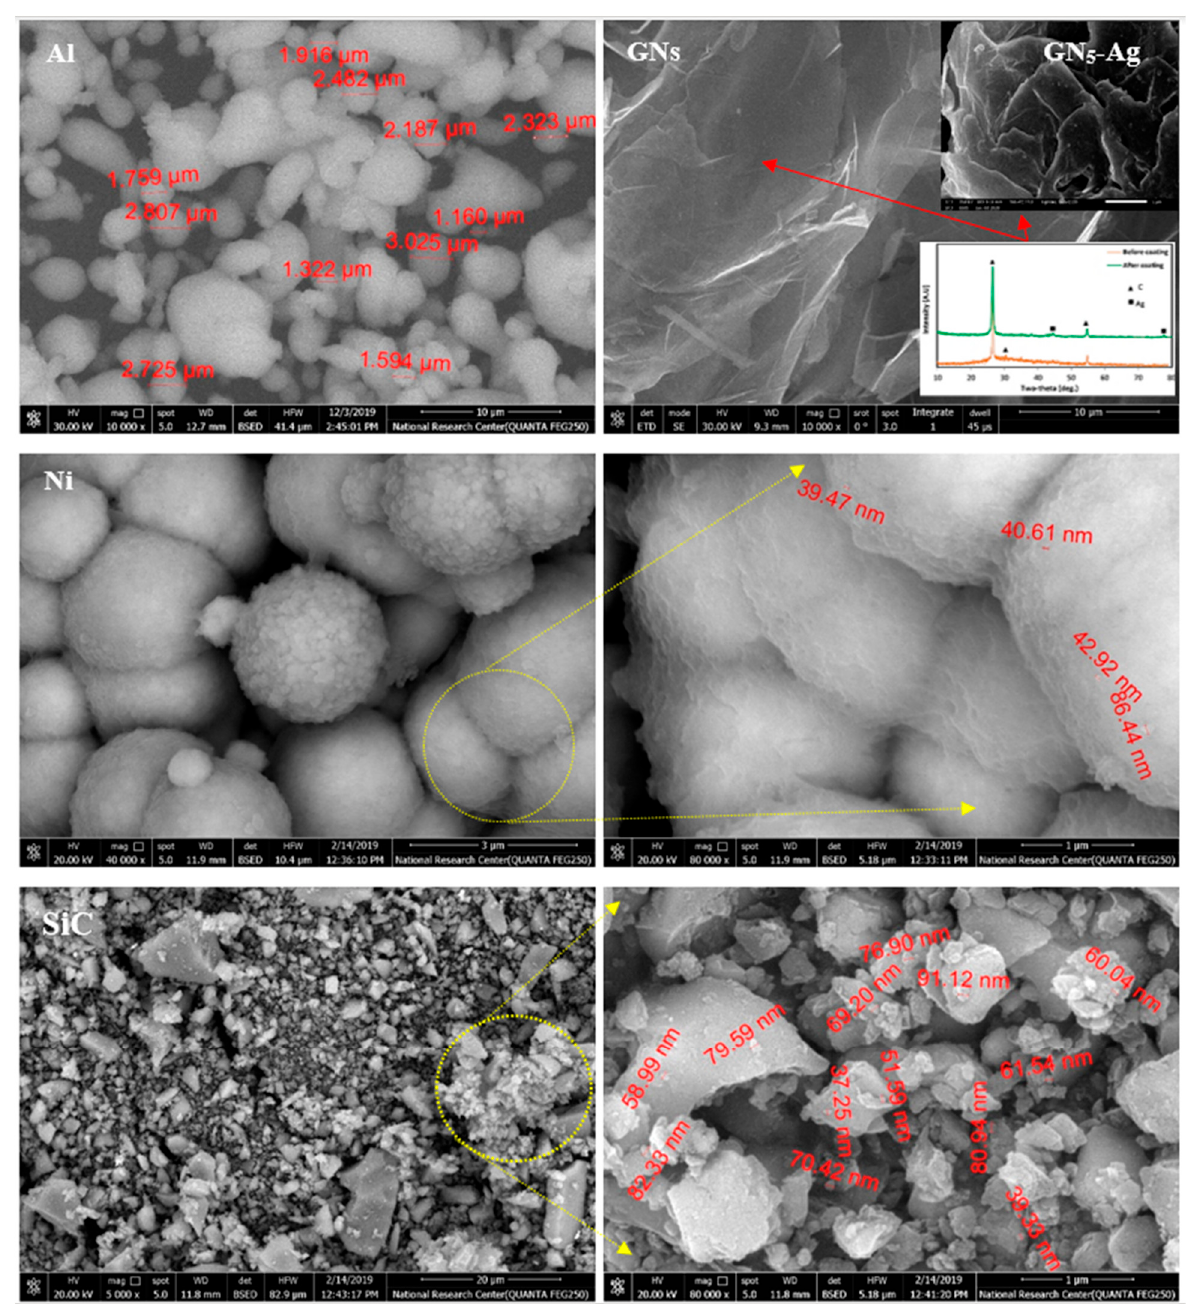
Figure 1. SEM (BSE) micrograph of pure Al, GNs, electroless-deposited Ni, and milled SiC